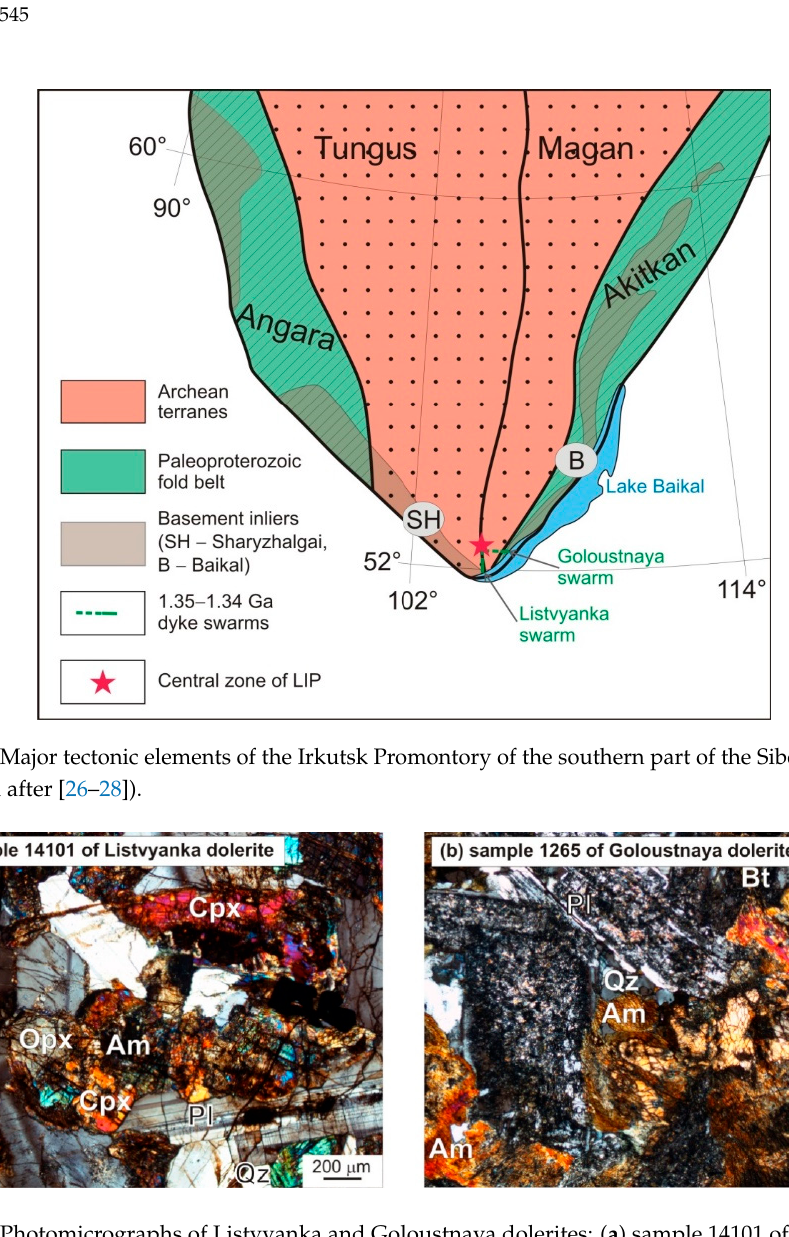
Figure 4. Geological scheme of the Goloustnaya area, showing the locations of dykes of Goloustnaya swarm (modified after [25]). The numbers of dykes according to Table 1 are shown in circles. 3. Methods Five samples from two Listvyanka dykes and 19 samples from five Goloustnaya dykes were collected for analysis of major ‐ oxide, trace ‐ element, REE abundances, and Nd isotope systematics. Analytical data are summarized in Tables 1 and 2.